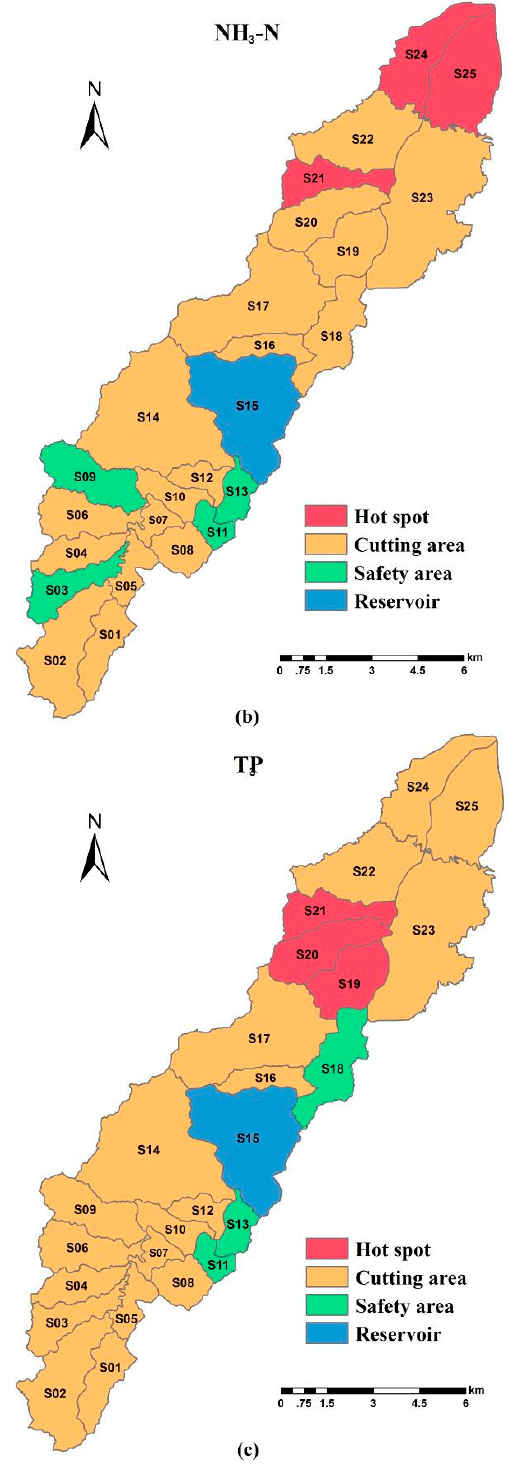
Figure 11. The spatial pattern of hot spots (the areas with the top three WEC reductions) and safety areas (the areas with no need to cut) of the Xian-Jiang sub-basins: ( a ) the spatial pattern of cutting areas for COD ; ( b ) the spatial pattern of cutting areas for NH 3 -N; and ( c ) the spatial pattern of cutting areas for TP.